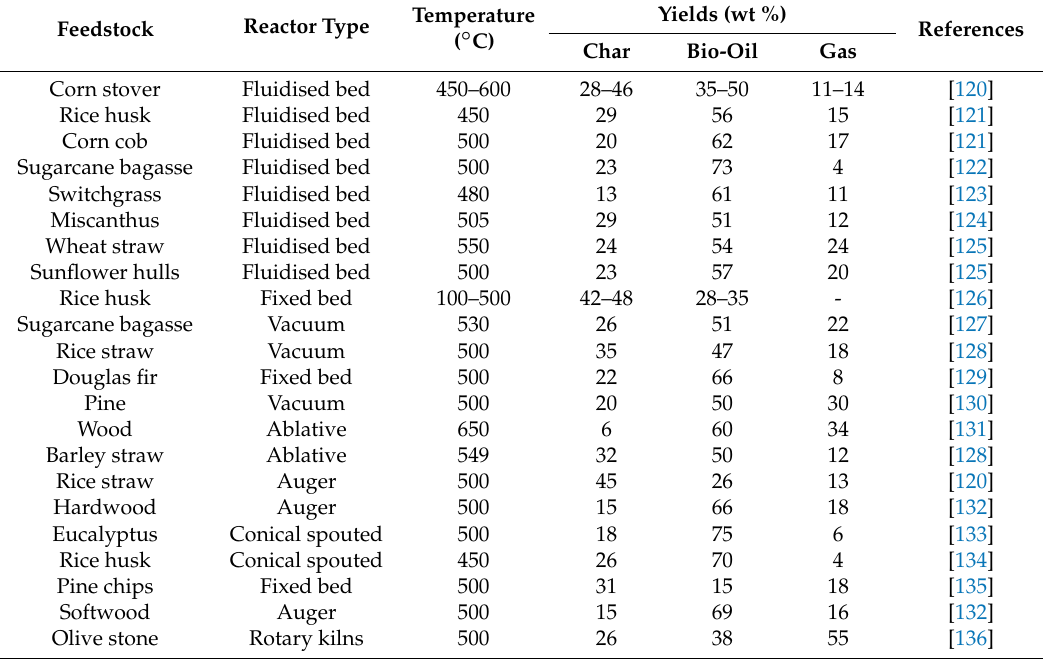
Table 6. Summary of previous researches on biomass conversion.